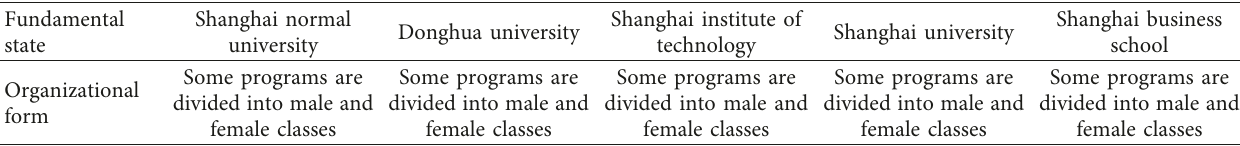
Table 3: The organization form of P.E. curriculum in experimental colleges and universities.